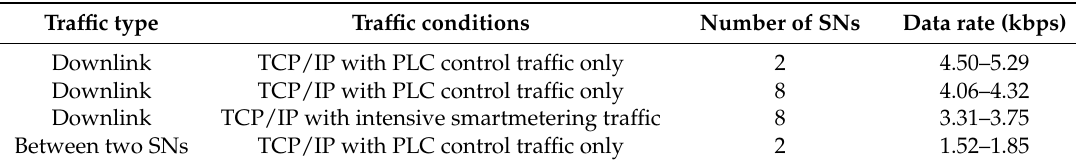
Table 1. IP over narrowband high data rate (NB HDR) powerline communications (PLC) performance measurements. Service Nodes: SNs; TCP: transmission control protocol; IP: Internet